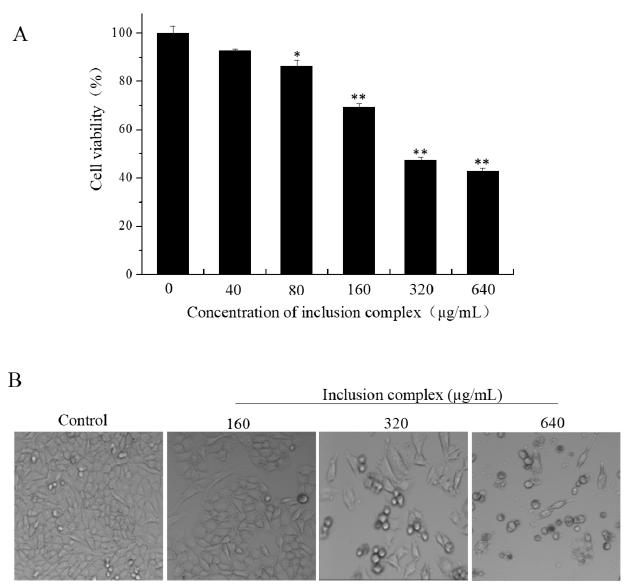
Figure 7. Effect of inclusion complex treatment for 72 h on cell viability of A375 cells. ( A ) Dose- dependent cytotoxic effects of inclusion on A375 cells. The cells were treated with different concentrations of inclusion complex and incubated for 72 h. Cell viability was determined by the CCK-8 assay. All data were obtained from three independent experiments are presented as the means ± SD. p < 0.05 (*) or p < 0.01 (**) vs. control group; ( B ) Morphological changes of A375 cells as examined by phase-contrast microscopy (magnification, 200×). The images shown here are representative of three independent experiments with similar results.